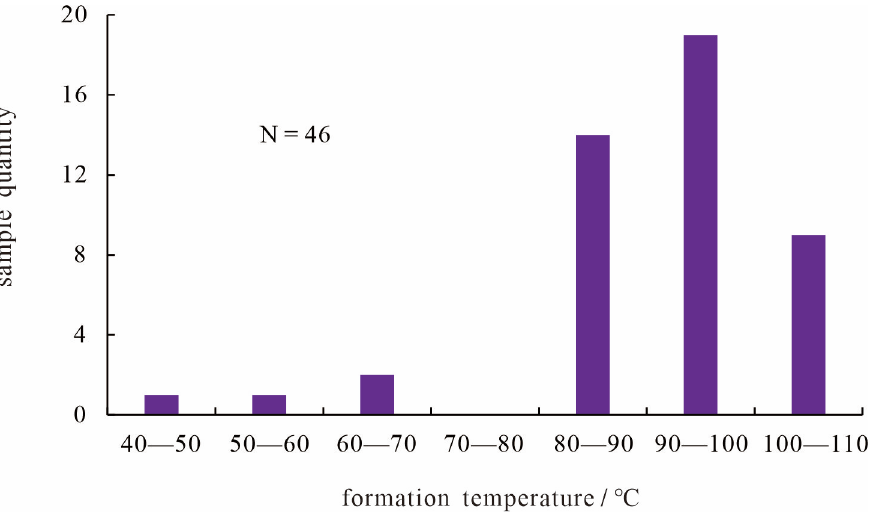
Figure 12. Formation temperature of calcite cements in study area recovered by oxygen isotopes results.